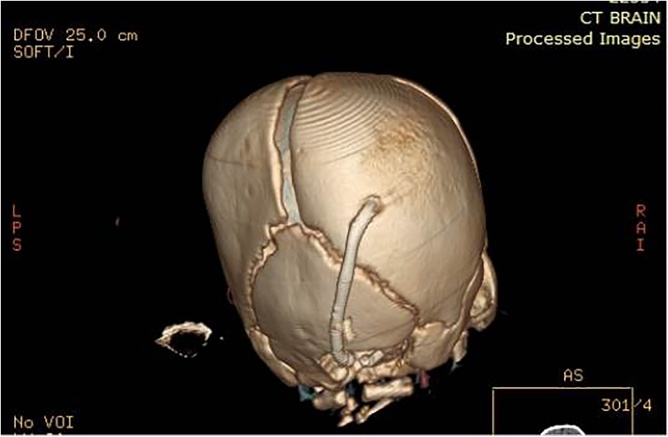
3D CT scan, depicting the course of the inserted tube from the occipital horn to the cisterna magna and its course superficial to the bone.